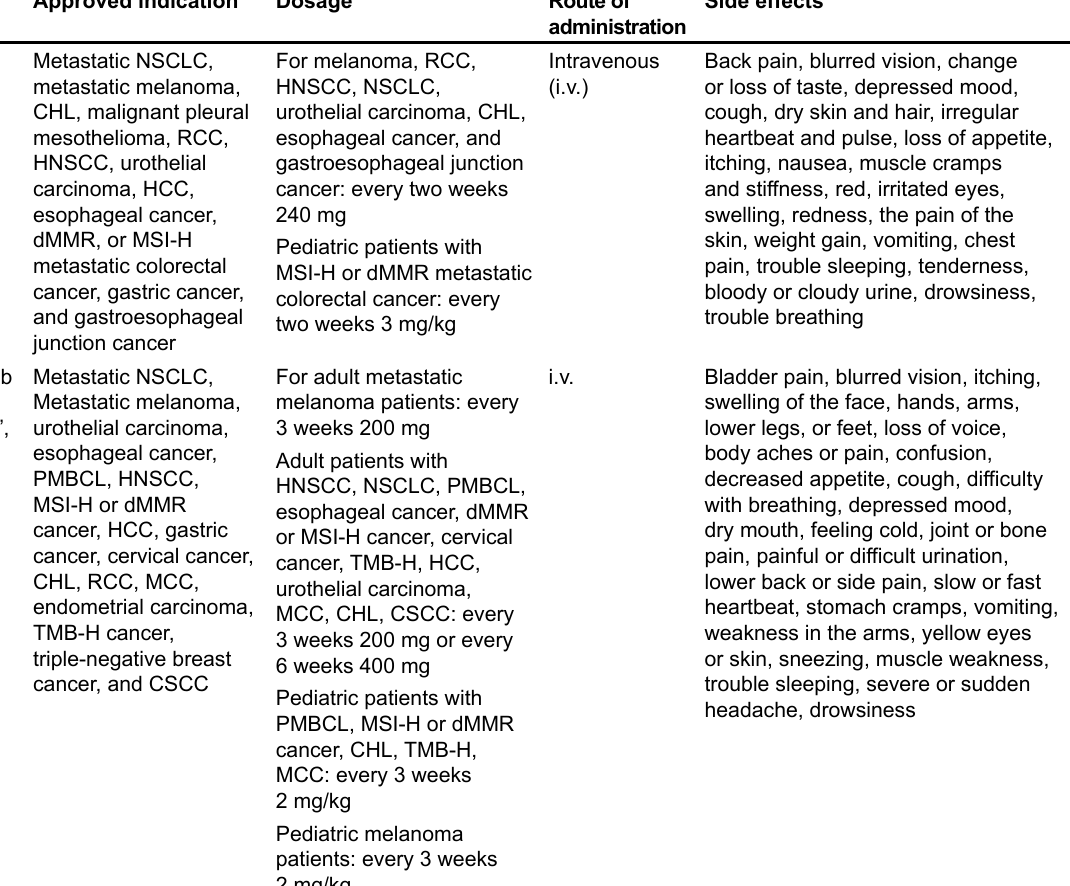
Table 1. Currently available drugs that target PD-1/PD-L1 pathway